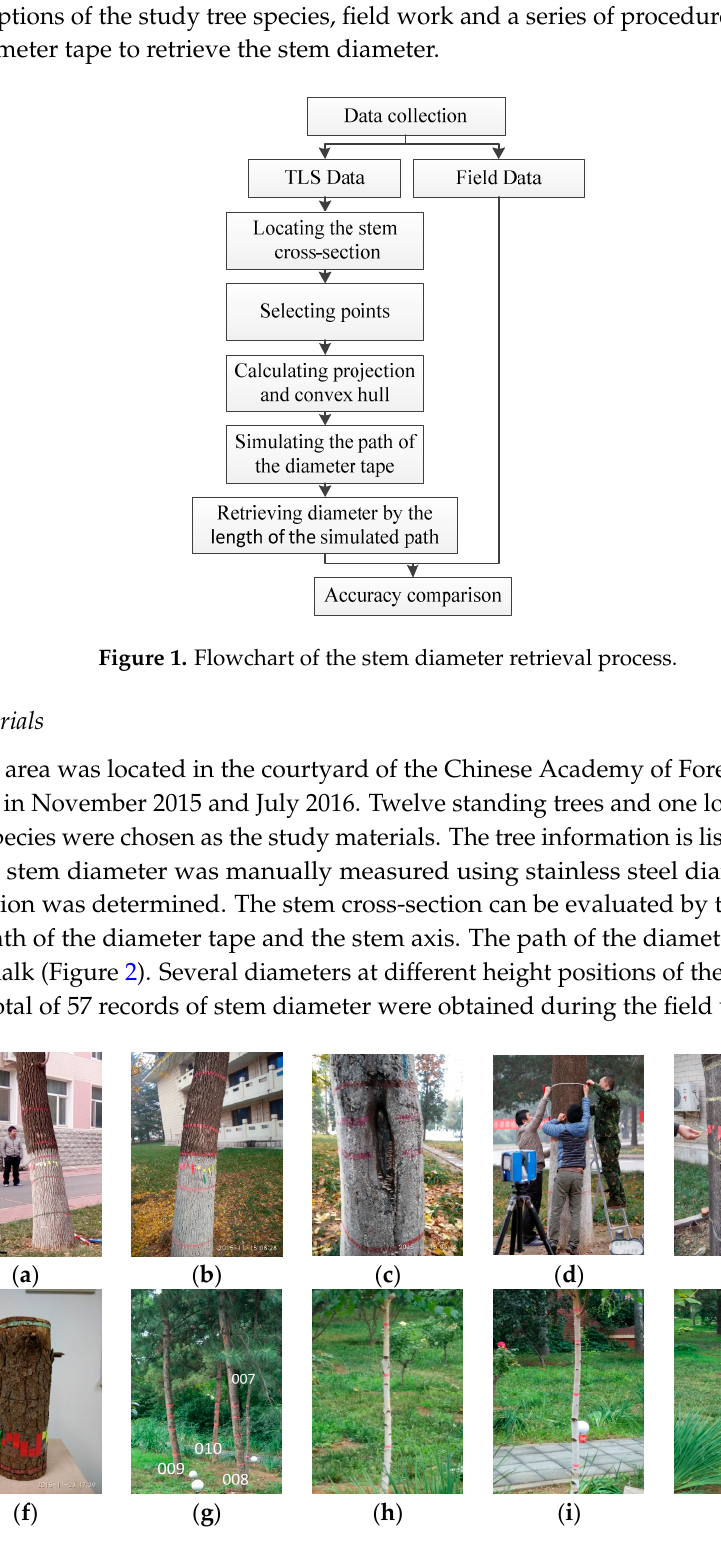
Figure 2. Field work scenes. ( a ) Tree 001; ( b ) Tree 002; ( c ) Tree 003; ( d ) Tree 004; ( e ) Tree 005; ( f ) Log 006; ( g ) Tree 007, Tree 008, Tree 009, and Tree 010; ( h ) Tree 011; ( i ) Tree 012; ( j ) Tree 013.